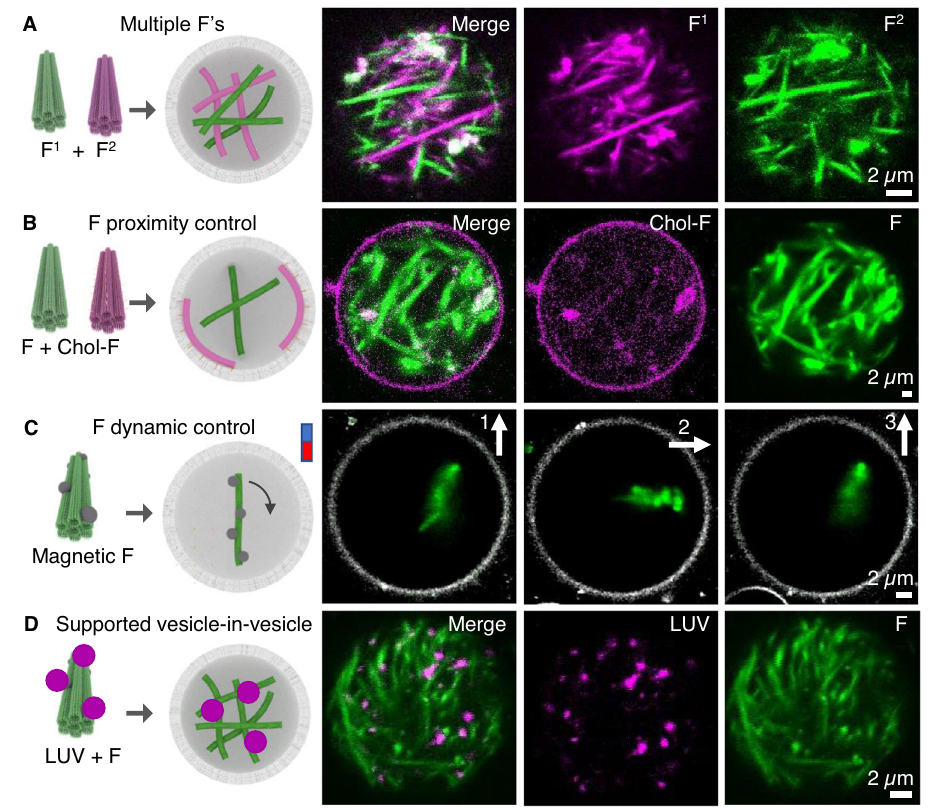
Fig.3|ShowcasingDNAcytoskeletalcomplexityandbiophysicalcontrolinside protocells. A Two fi ber types compartmentalized inside GUVs, schematic repre- sentation(left),andcorrespondingCLSMimages(right), fi ber1(magenta)and fi ber 2 (green), scale bar 2 µ m. B Controlling location of cytoskeletal DNA fi bers using cholesterol lipid anchors, schematic representation, cholesterol modi fi cations (orange spheres) and corresponding CLSM images, cholesterol fi bers (magenta)